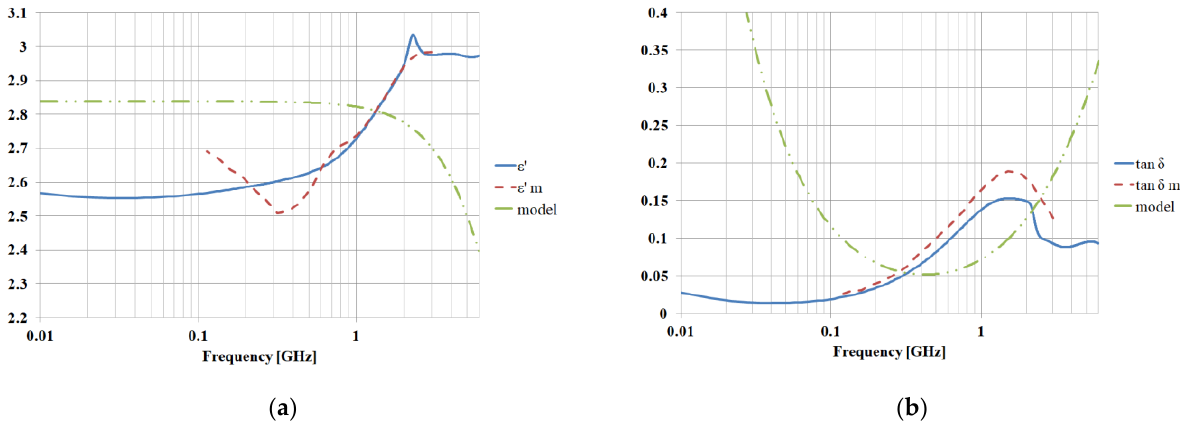
Figure 17. Extending the measurement frequency range through simulations (800 nm Fe simulations between 0.01 GHz and 6 GHz); ( a ) dielectric permittivity and ( b ) loss angle